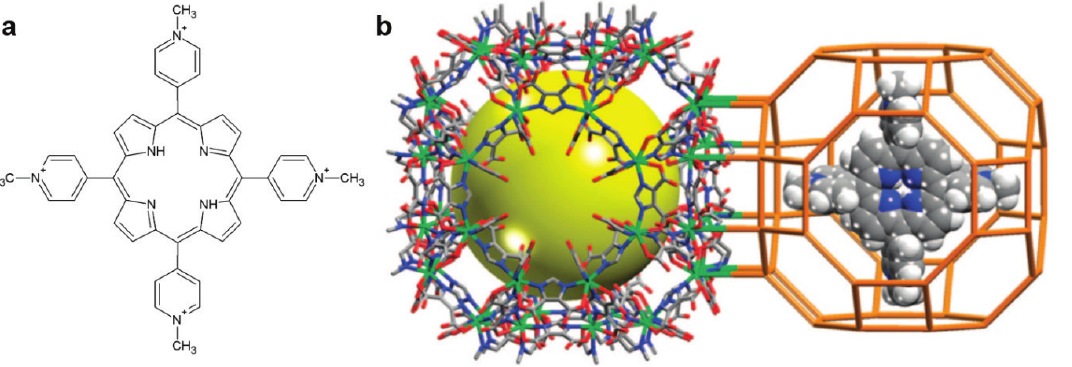
Figure 8: (a) Structure of TMPyP; (b) Structural representation of rho-ZMOF encapsulating TMPyP [109]. Reprinted with permission from Ref. [109]. Copyright © 2008, American Chemical